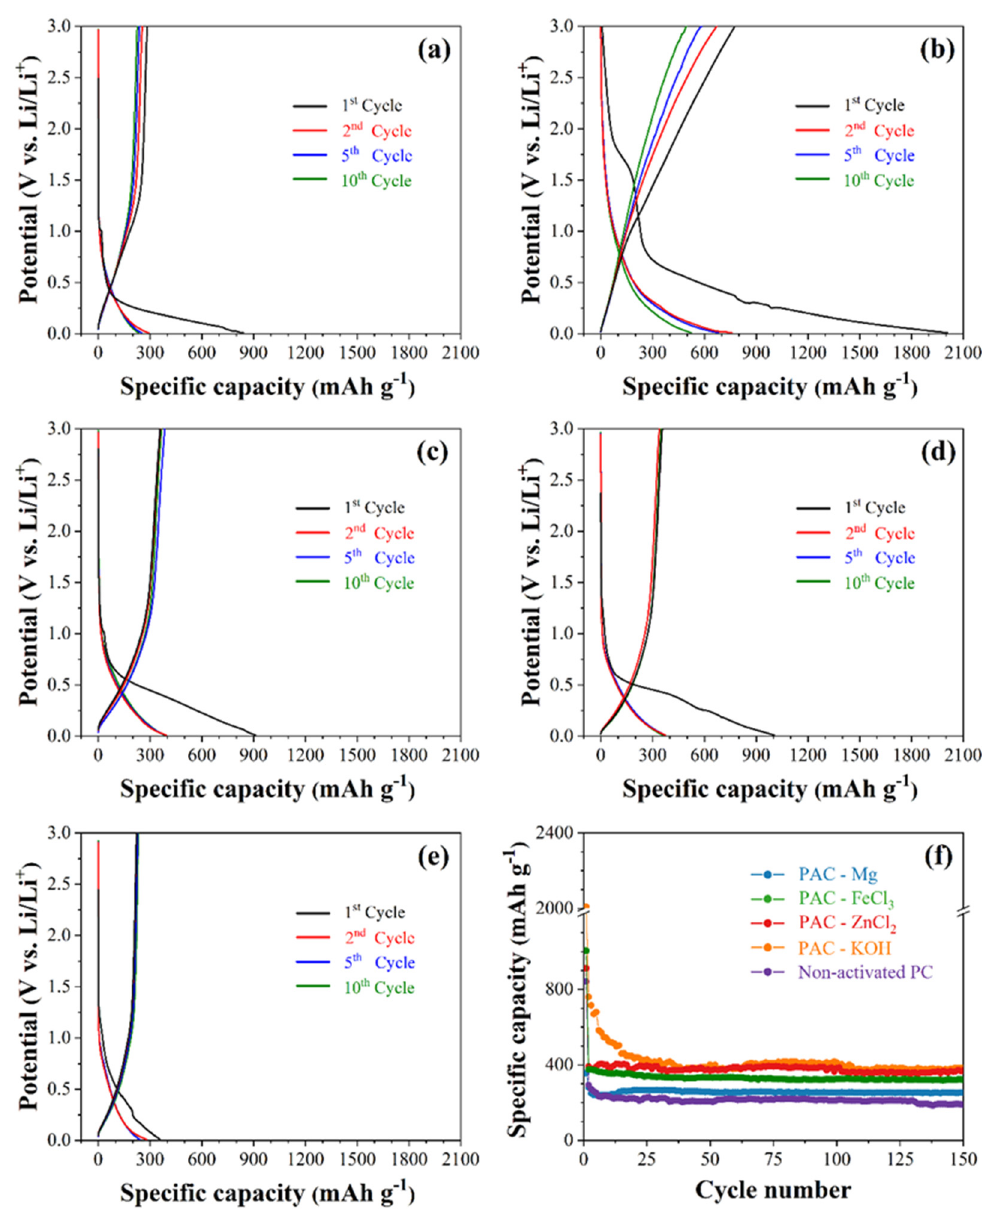
Figure 4. Electrochemical measurements of all prepared electrodes as anode materials for LIBs: discharge/charge curves of ( a ) non-activated PC and PAC electrodes using different activating agents of ( b ) KOH, ( c ) ZnCl 2 , ( d ) FeCl 3 , and ( e ) Mg; ( f ) cycle performance of all samples at 100 mA g − 1 . At the 150th cycle, the non-activated PC, PAC-KOH, PAC-ZnCl 2 , PAC-FeCl 3 , and PAC-Mg electrodes have the specific capacities of 189, 383, 370, 320, and 252 mAh g − 1 ,